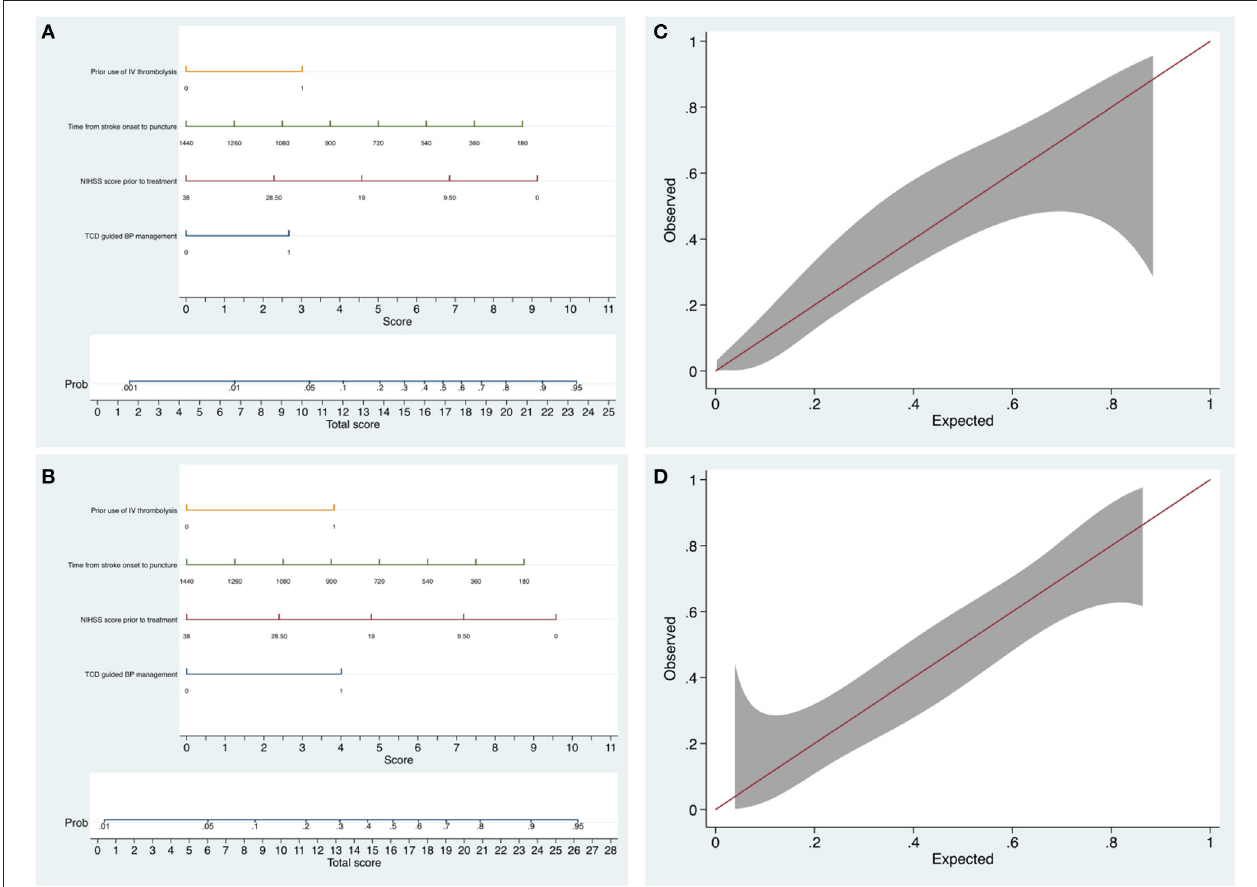
FIGURE 4 | The nomograms and calibration plots for predicting the probability of excellent outcome and favorable outcome at 3 months. (A) The nomogram for predicting the probability of mRS 0–2. (B) The nomogram for predicting the probability of mRS 0–3. (C) The nomogram calibration plot for predicting the probability of mRS 0–2. Calibration plot displaying the observed proportion of patients who have functional independence in the PSM cohort with 95% CIs (vertical lines) against the predicted probability. (D) The nomogram calibration plot for predicting the probability of mRS 0–3.